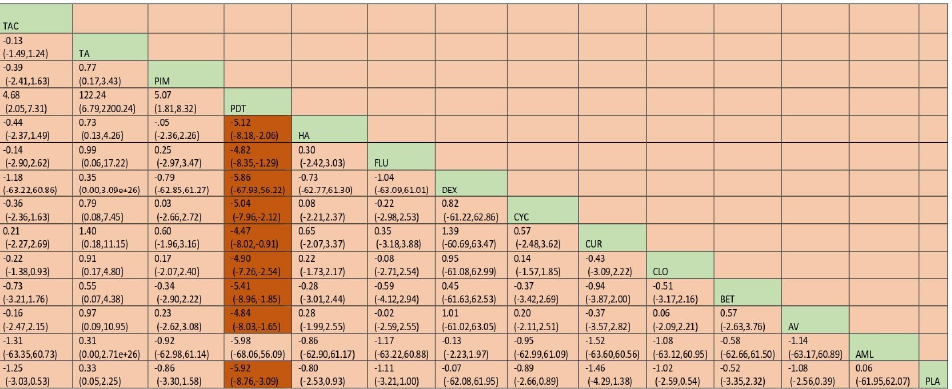
Figure 21. Network plot: Clinical Score (subgroup analysis). Abbreviations: AML, amelexanox paste; AV, aloe vera; CUR, curcumin gel; PDT, photodynamic therapy; PLA, placebo; PUR, purslane; TAC, tacrolimus; FLU, flucinonide acetonide; CLO, Clobetasol propionate; PIM, pimecrolimus; BET, betamethasone; TA, triamcinolone acetonide; DEX, dexamethasone; CYC, cyclosporine. The green highlights indicate the interventions and the dark highlights indicate the significant re ‐ sults.